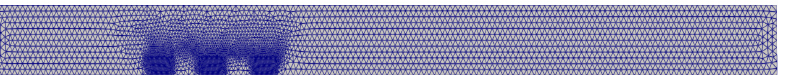
Figure 3. Computational mesh of the forced convection cooling region on a rectangular block containing 7984 linear triangular elements.